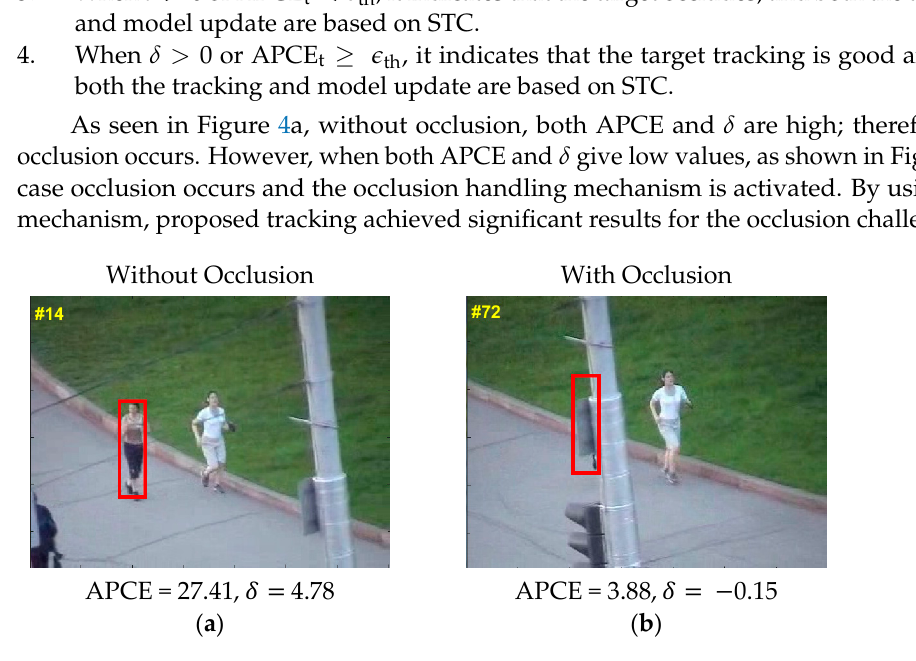
Figure 4. Occlusion detection mechanism. Pictures in the figure are part of OTB-100 dataset [26].